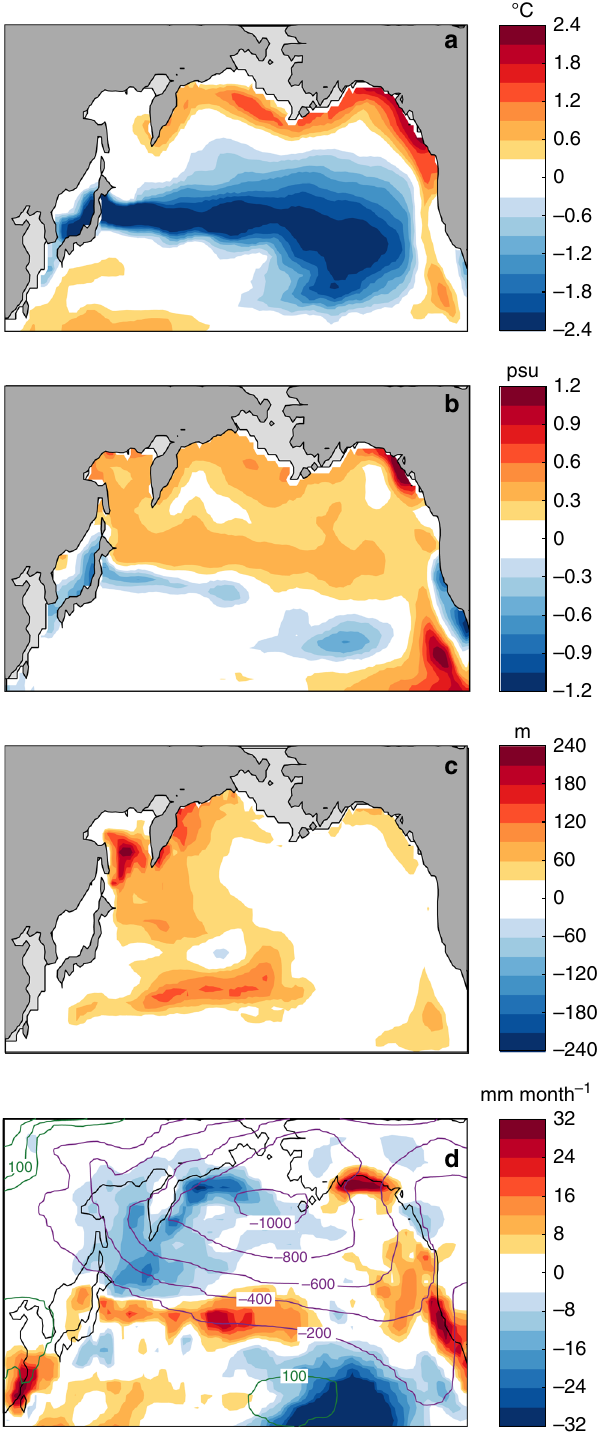
Fig. 2 Modelled North Paci fi c change due to AMOC slow-down. a Winter SST anomalies of HS-1 to the LGM; b The coeval winter SSS anomalies; c The coeval wMLD anomalies; d The coeval change in winter atmospheric circulation. In d , the shading colours show net precipitation change, and the green and purple lines describing positive and negative change in sea level pressures, respectively. Here, the negative values of sea level pressure change over the subarctic Paci fi c Ocean imply an intensi fi ed Aleutian Low system in HS-1